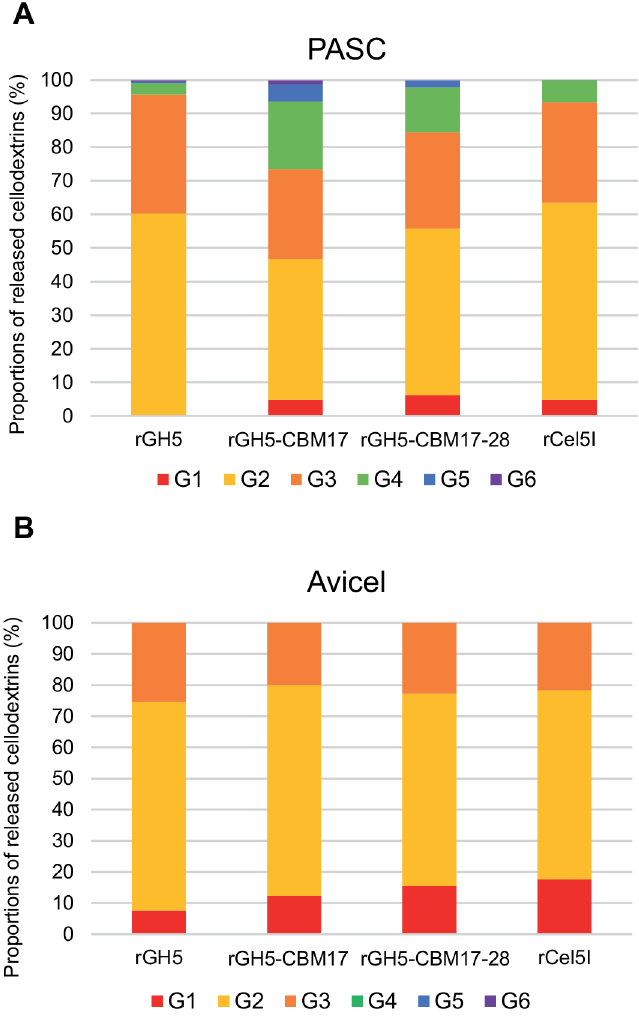
Fig 4. Analysis of the cellodextrins released by the various Cel5I forms on insoluble celluloses. Soluble sugars generated by 0.1 μ M of enzyme after 15 min of incubation on amorphous cellulose PASC (A) or 24 h on crystalline cellulose Avicel (B), were identified and quantified by